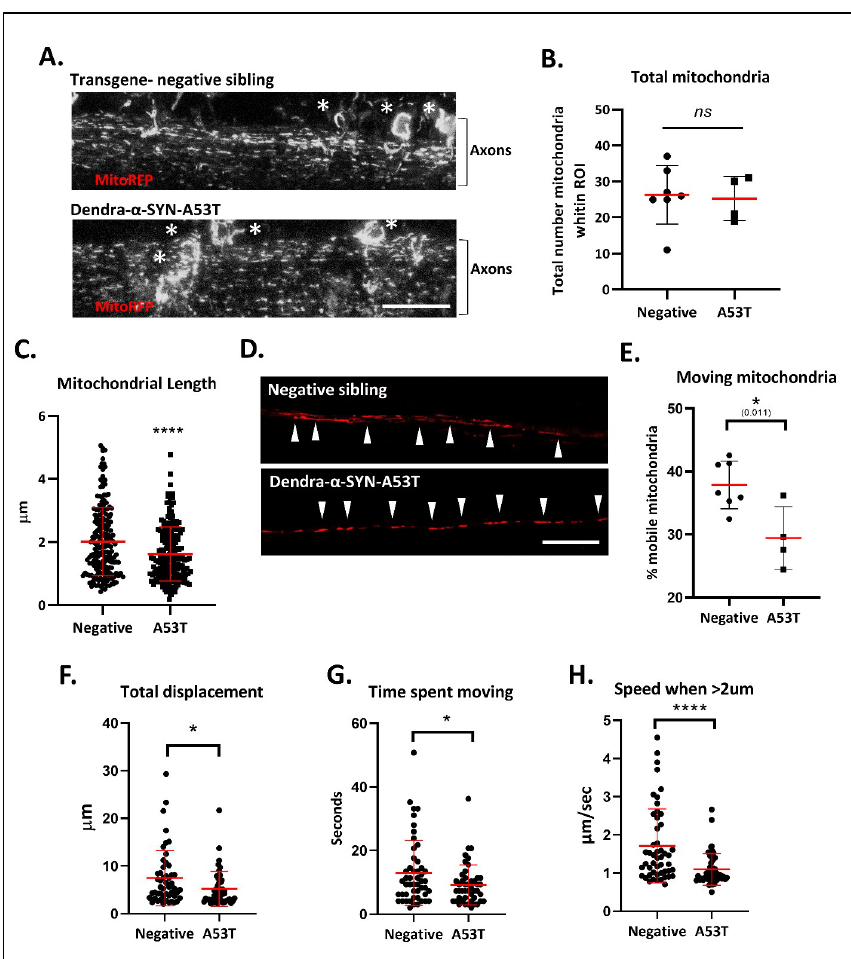
Figure 4. Defects in mitochondrial morphology and axonal transport. ( A ) Representative confocal images (max intensity z-stack projections) of labelled mitochondria in the spinal cord 72 h after the injection of NeuroD :mitoRFPTag construct into Dendra- α -SYN-A53T with pan-neuronal expression and transgene-negative siblings. Labelled mitochondria could be observed in the soma (white *) and the axonal projections (Axons). Scale bar represents 50 µ m. ( B ) Graph represents the total number of mitochondria quantified within the same ROI area, localised to the center of the spinal cord in transgene-negative fish (Negative) and Dendra- α -SYN-A53T fish (A53T). No changes in total number were found, allowing the analysis of mitochondrial morphology and transport in comparative experiments. Data represented as mean (red line) ± s.d. ( N ≥ 4 fish; ns p > 0.05 vs. negative) ( C ) Quantification of mitochondrial length within the same ROI. Mitochondria in Dendra- α -SYN-A53T fish were significantly smaller than in negative siblings. Data represented as mean (thick red line) ± s.d. ( N = 200 mitochondria from minimum 4 fish; **** p < 0.0001 vs. negative) ( D ) Representative confocal images of RFP-positive mitochondria in a single plane of focus showing individual axonal tracks in transgene-negative and Dendra- α -SYN-A53T fish injected with NeuroD :mitoRFPTag construct. Scale bar represents 20 µ m. ( E ) Graph representing the percentage of mobile mitochondria in single axons used for the motility analysis in videos. Data represented as mean (red line) ± s.d. ( N ≥ of 4 videos from independent fish within the same group; * p < 0.01 vs. negative). ( F – H ) Quantification of mitochondrial motion across 125 µ m of spinal cord axon in 1.03 s intervals. Overall mitochondrial transport was significantly reduced in Dendra- α -SYN-A53T-expressing axons compared to transgene-negative siblings. Mobile mitochondria in Dendra- α -SYN-A53T showed significantly less total displacement ( F ), less time moving ( G ) and, consequently, a slower speed ( H ). Data represented as mean (red line) ± s.d. ( N = 46 mitochondria per group; (* p < 0.05, **** p < 0.0001 vs.